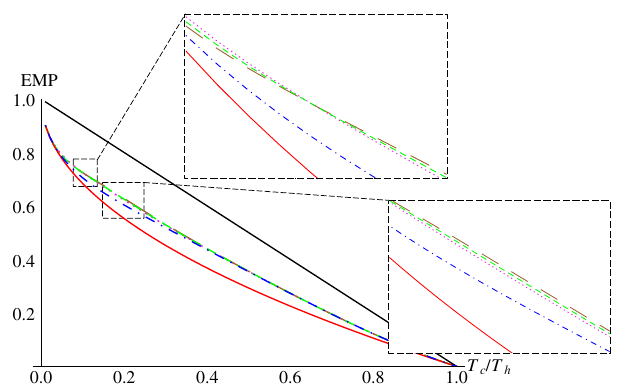
FIG. 9. EMP as a function of the ratio of bath temperatures for two statistical anyons with p B = 1 (long dashed, brown), p B = 1 / 2 (short dashed, green), p B = 0 (dotted, dark pink), and two distinguishable quantum particles (dot dashed, blue) in two dimensions. The Curzon-Ahlborn efficiency (solid, red) is given in comparison. The bottom inset highlights the range of bath- temperature ratios at which bosonic working mediums display the greatest EMP and the top inset highlights the critical point and transition to the region where fermionic working mediums begin to outperform bosonic ones. Operation is in the quan- tum regime corresponding to (cid:2) ω 2 / k B T c = 10. Parameters are = α = γ = 1, and τ = τ = α c h c h